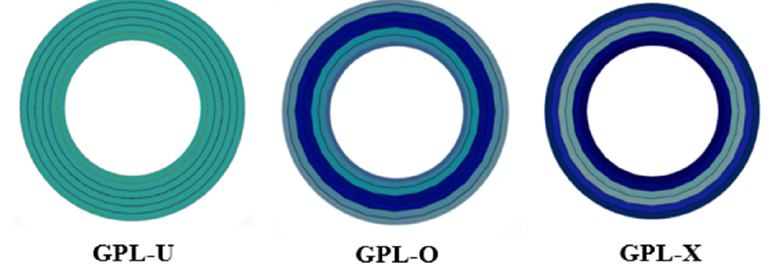
Figure 1. GPLRC fluid ‐ conveying pipe.